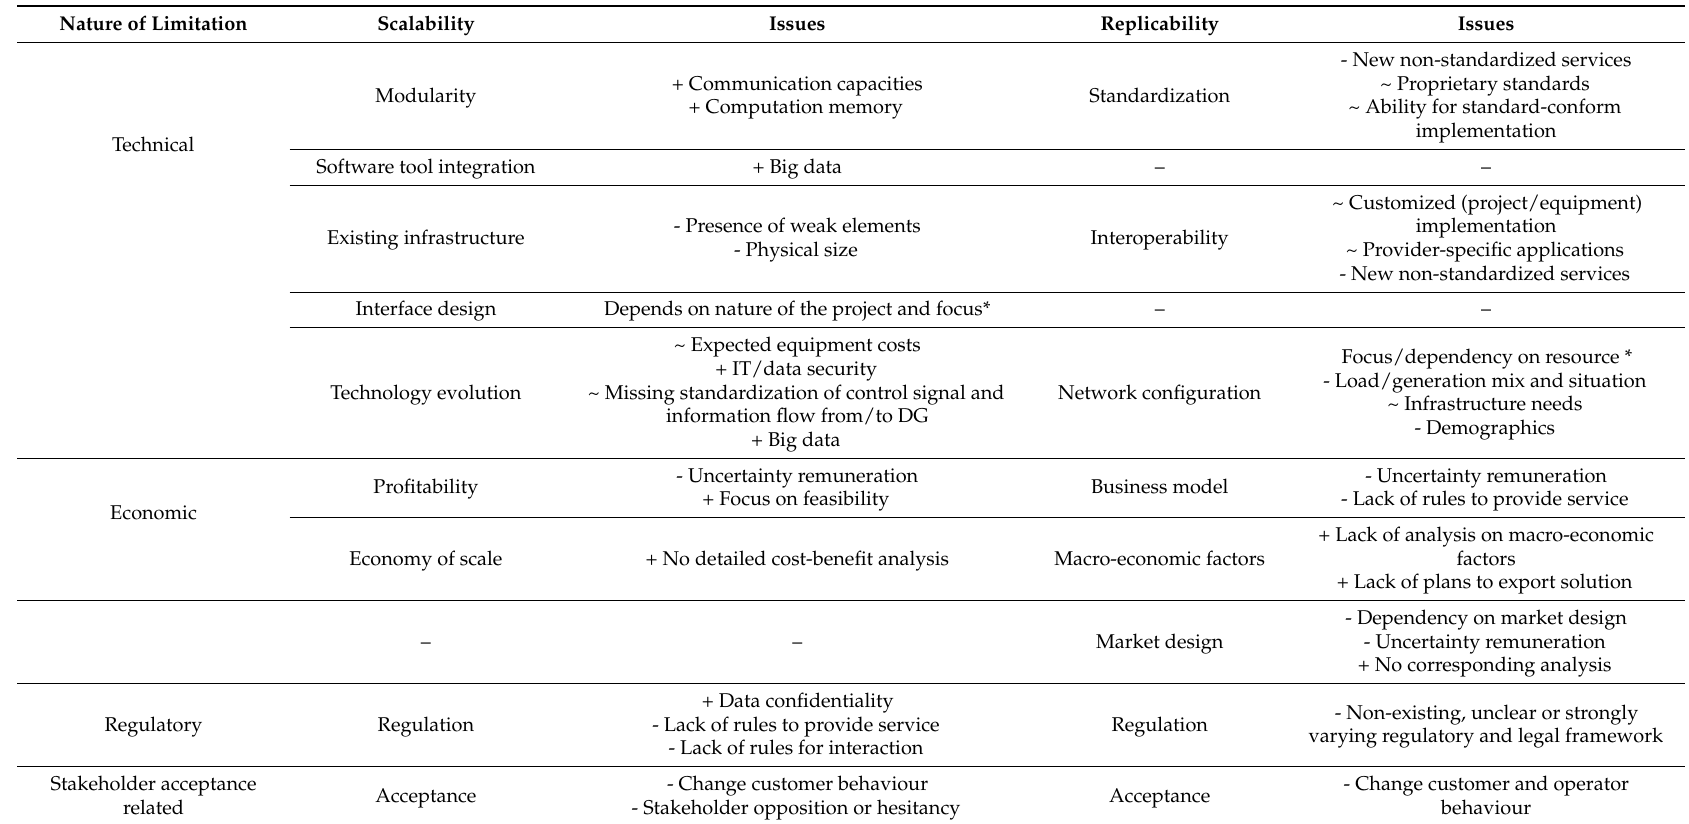
Table 3. Limitation and challenges with regard to scalability and replicability